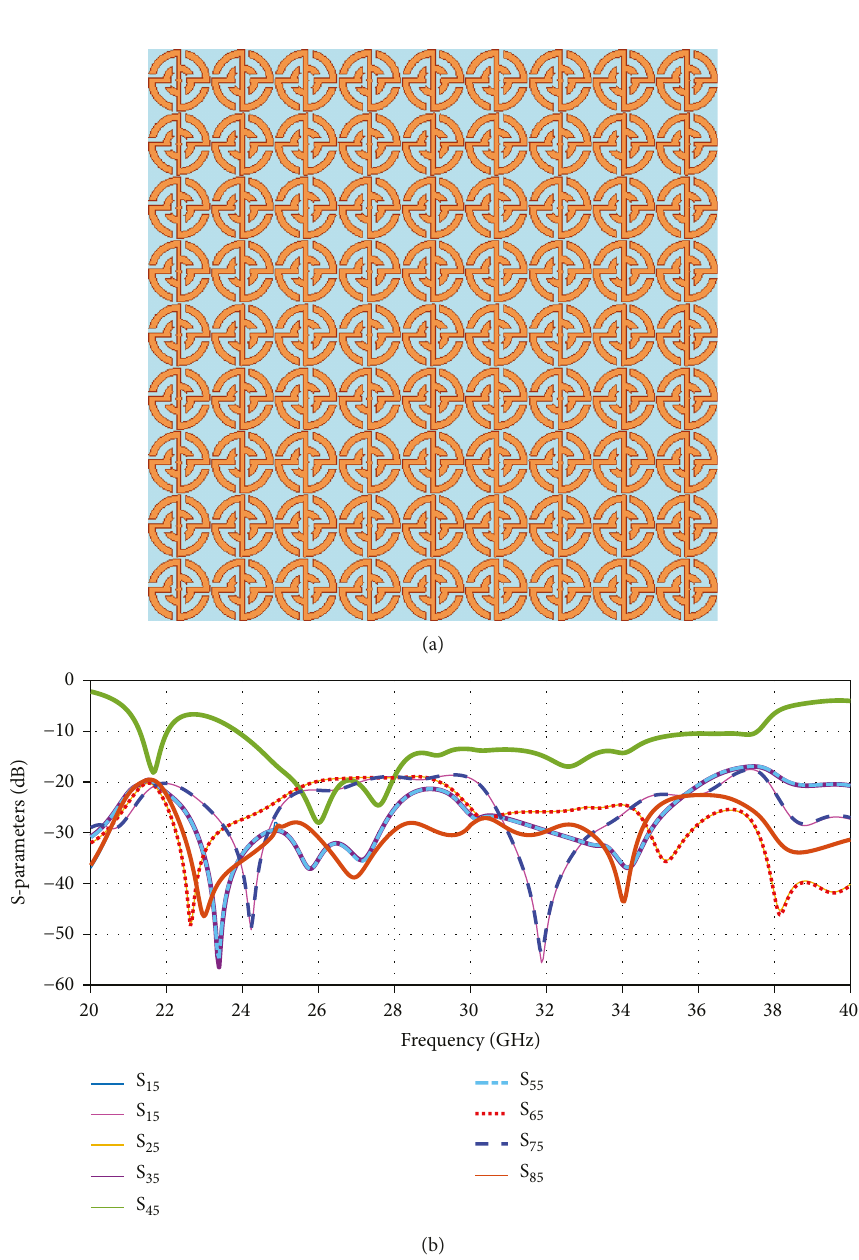
Figure 6: (a) Geometry and (b) S-parameters of the 9 × 9 MIMO